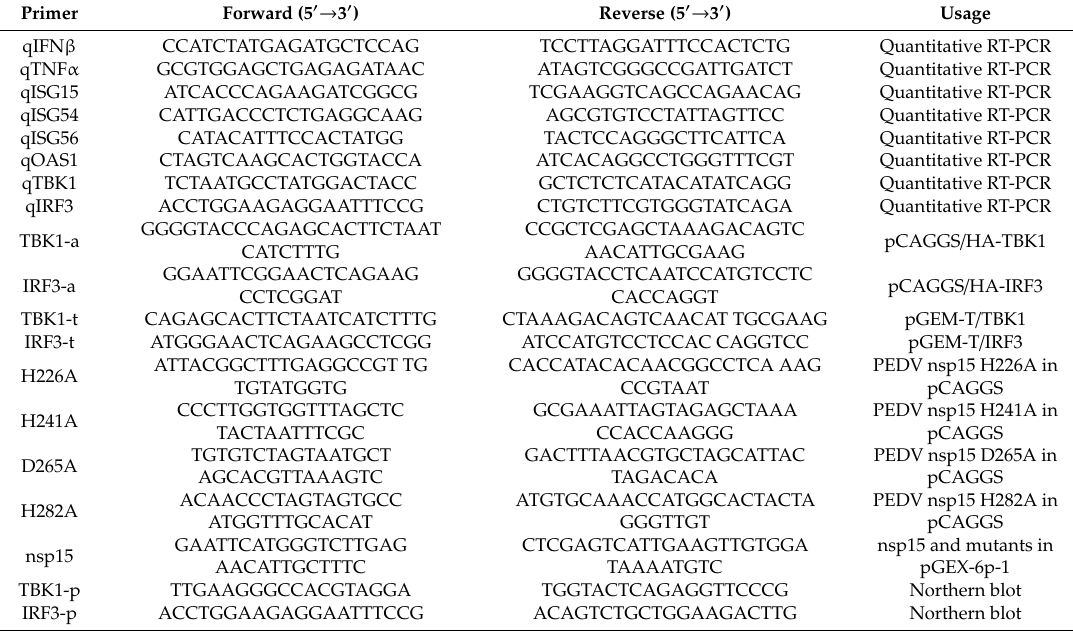
Table 1. Real-time PCR primers used in this